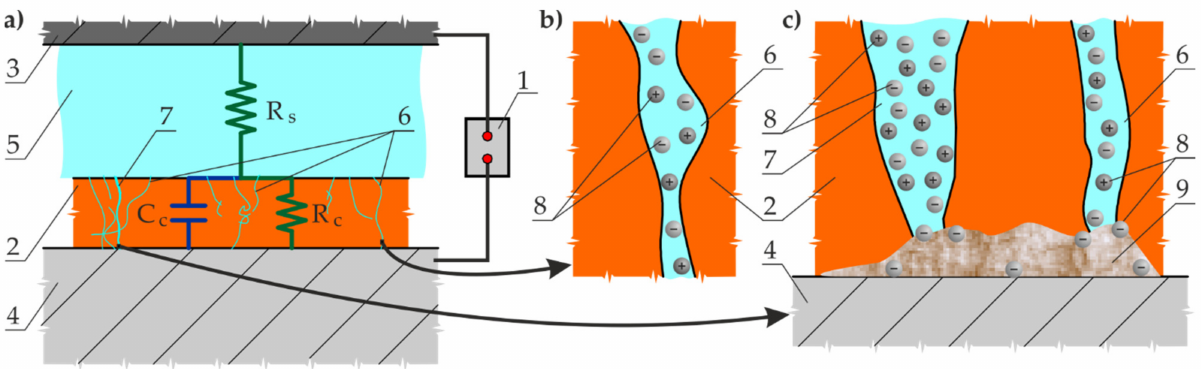
Figure 1. Scheme of impedance measurements of paint coatings on basic metal: ( a ) cross-section of paint-coated fragment of metal; ( b ) moisture and ions in the coating pore, the presence of which cause the current flow; ( c ) an increase in the number of pores and defects in the coating during localised corrosion, resulting in an increased conductivity. 1—analyser; 2—paint coating; 3—electrode; 4—coated metal; 5—electrolyte solution; 6, 7—pores and defects in the coating; 8—ions; 9—corrosion products; R s — impedance of electrolyte; R c —impedance of coating; C c —coating